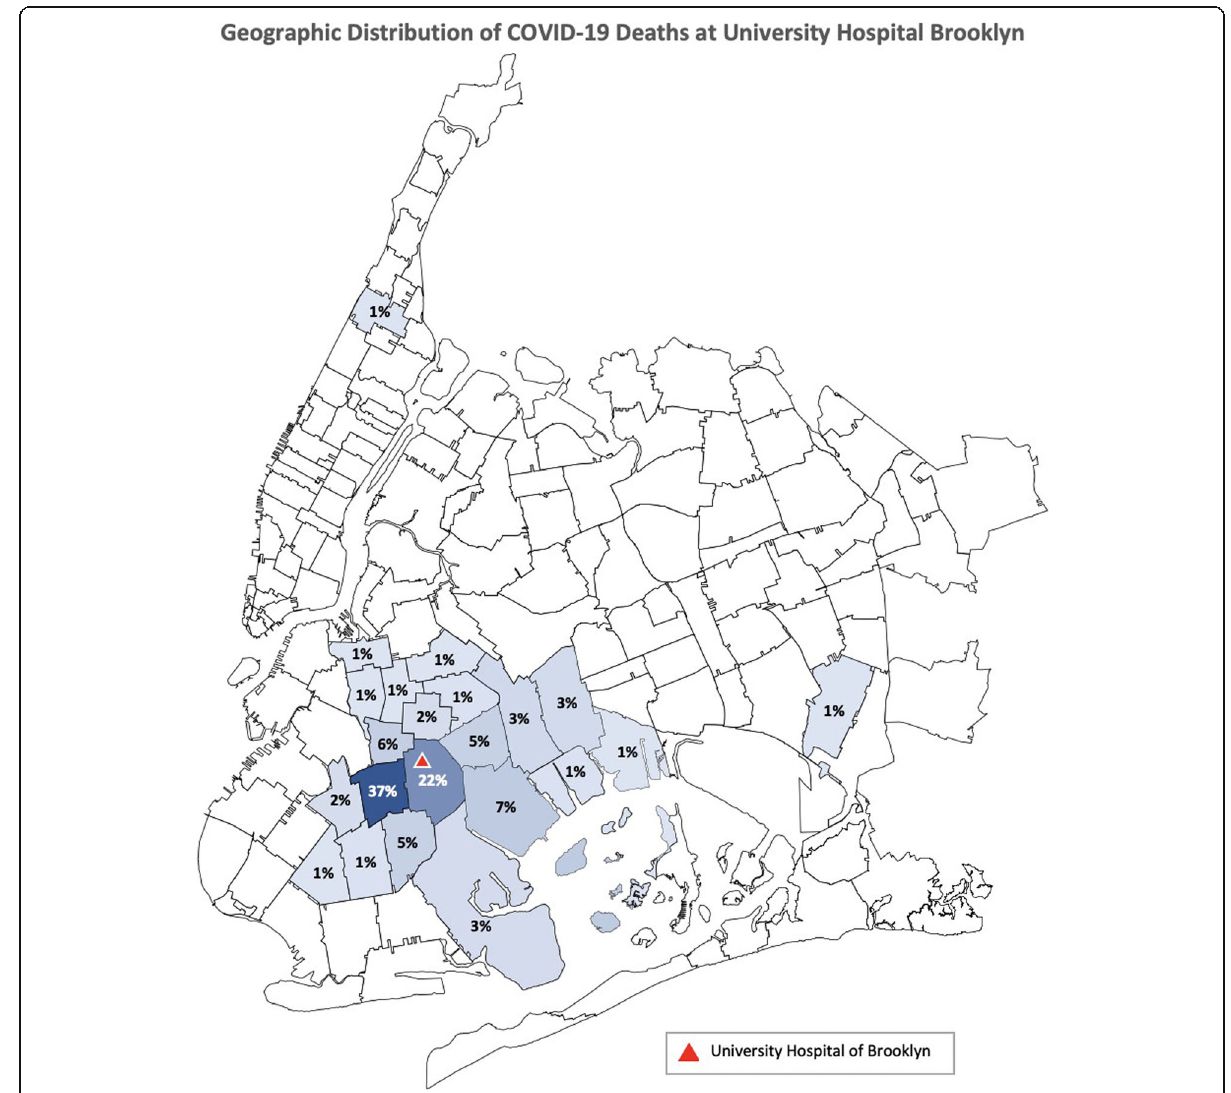
Fig. 1 Distribution of COVID-19 deaths by ZIP code in New York City, New